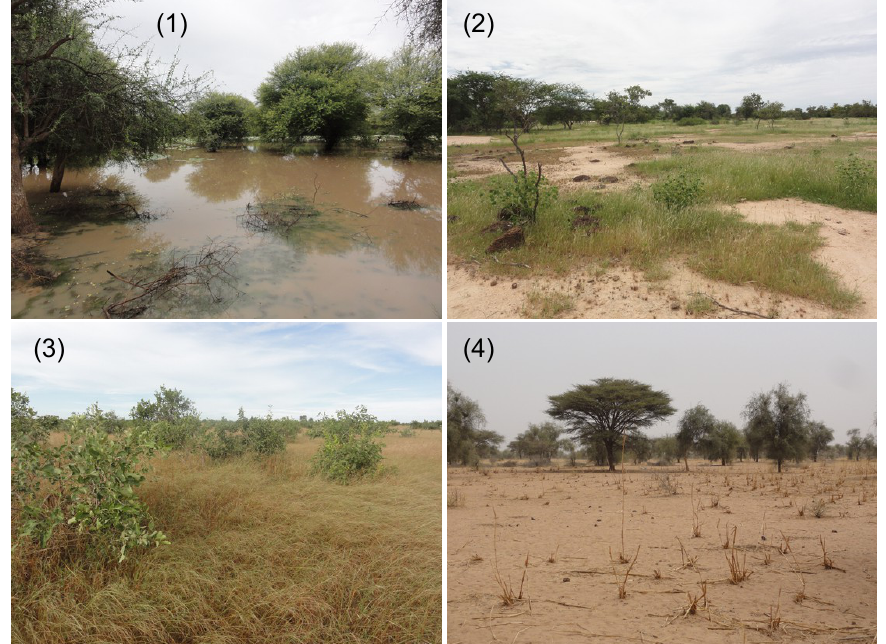
Figure 2. ( 1 ) A flooded Xour with Dek soils and large Acacia tomentosa trees; ( 2 ) Bowel region with exposed laterite; ( 3 ) a Dior peanut fallow with Combretum glutinosum